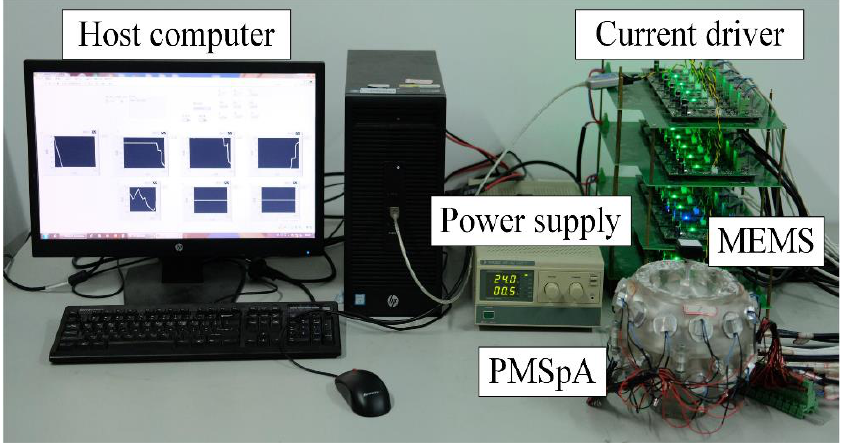
Figure 10. The experiment platform.